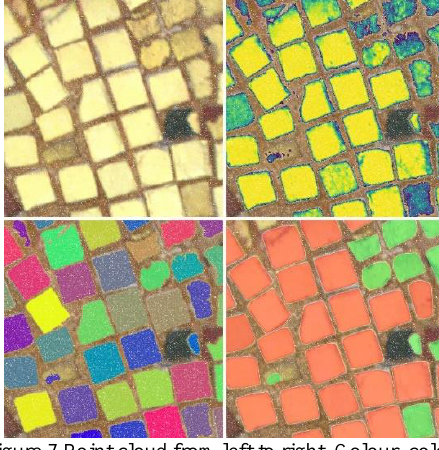
Figure 7 Point cloud from left to right, Colour, colour segmented, abstraction-based segmented, classified